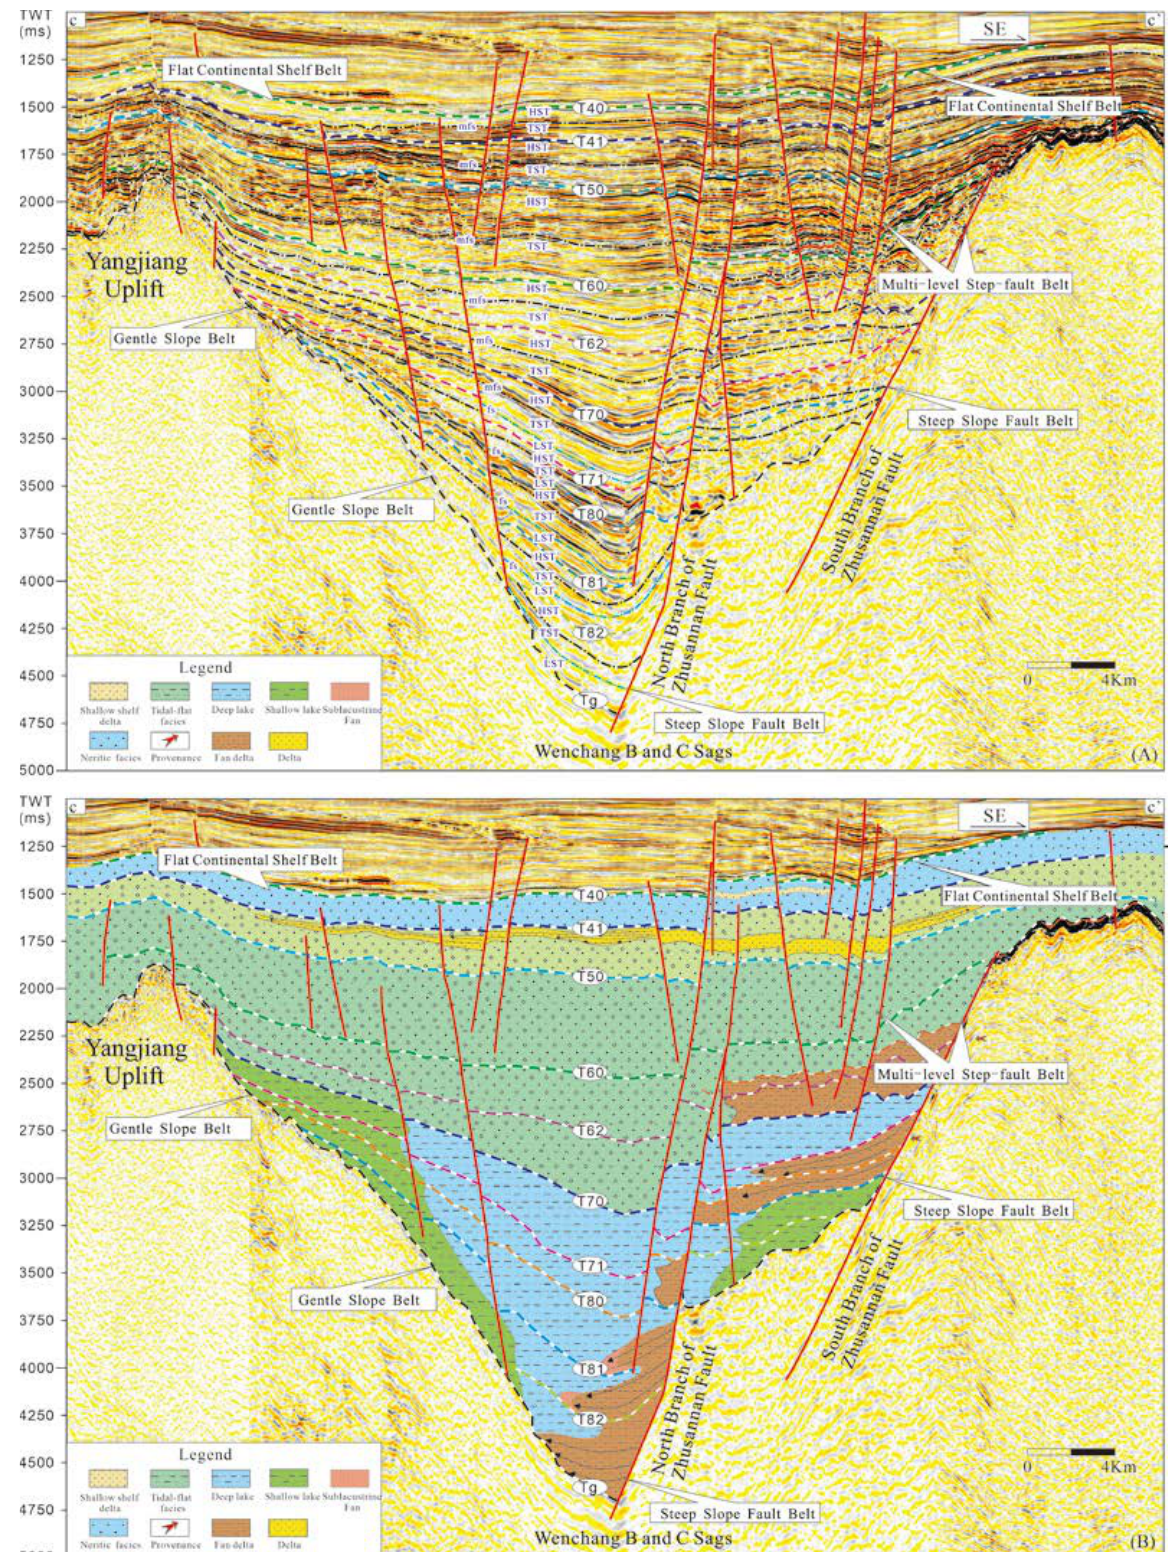
Figure 8. ( A ) interpreted seismic section cc’ showing seismic reflection characteristics and the distribution regions of different stratal stacking patterns; ( B ) the types of depositional facies and their distribution ranges in the section cc’ showing the depositional evolution from the Eocene to the Miocene. The location of section bb’ is shown in Figure 1.